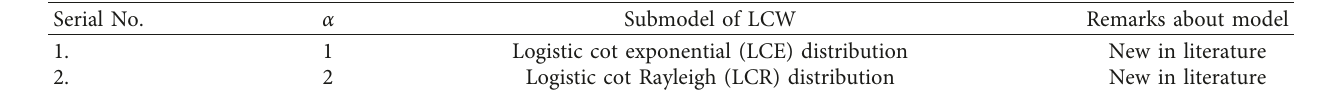
Table 2: Submodels of LCW.